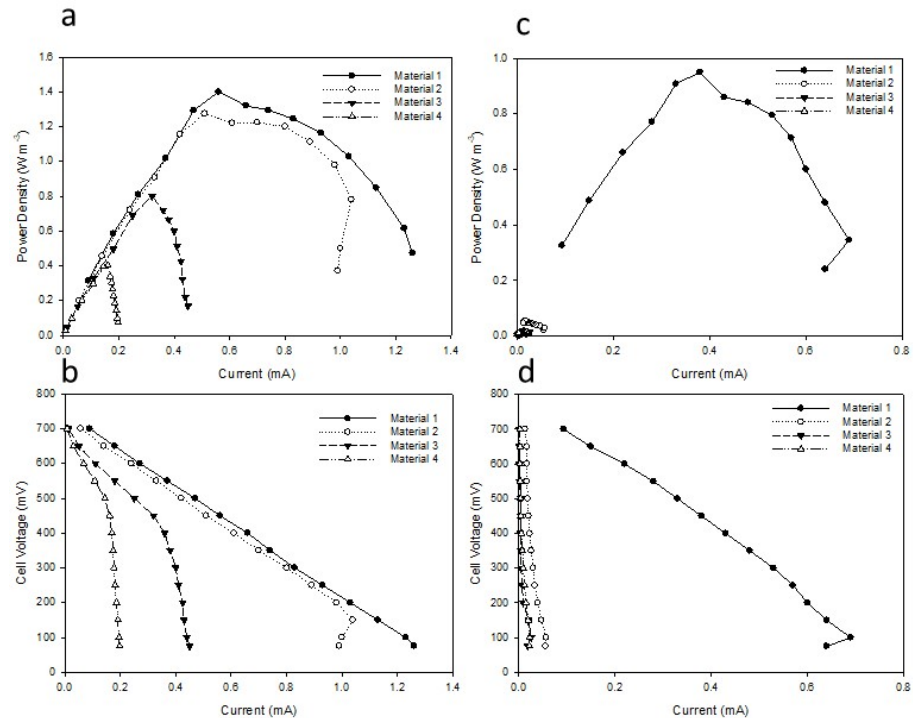
Figure 2. Cell potential and power density curves produced by Materials 1, 2, 3 and 4 operated in MFCs acclimated under closed-circuit ( a , b ) and open-circuit ( c , d ) conditions. Testing was carried out after 8 weeks of operation using a fixed resistance of 1000 Ω.